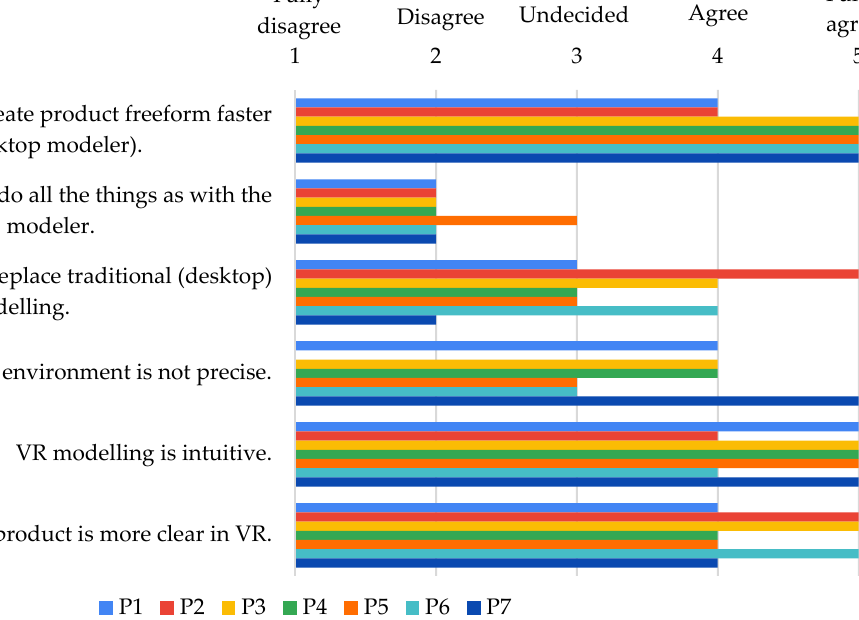
Figure 10. Participants’ opinions on modelling using VR technology after the study.